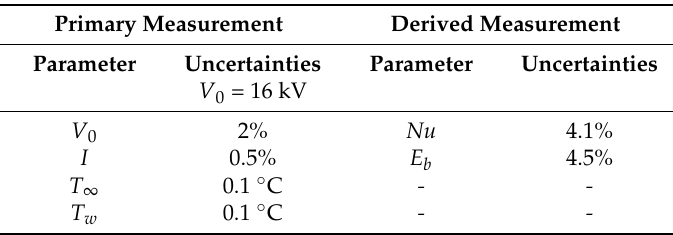
Table 1. Summary of estimated